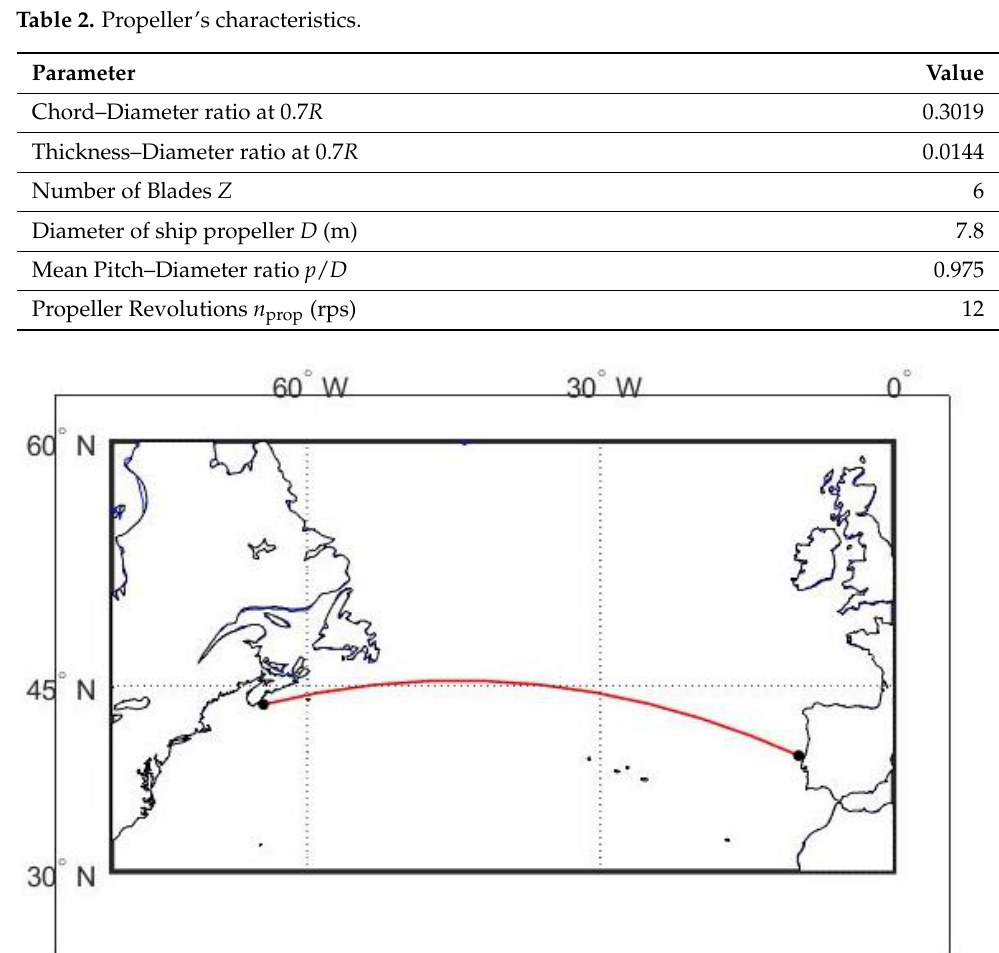
Table 2. Propeller’s characteristics.